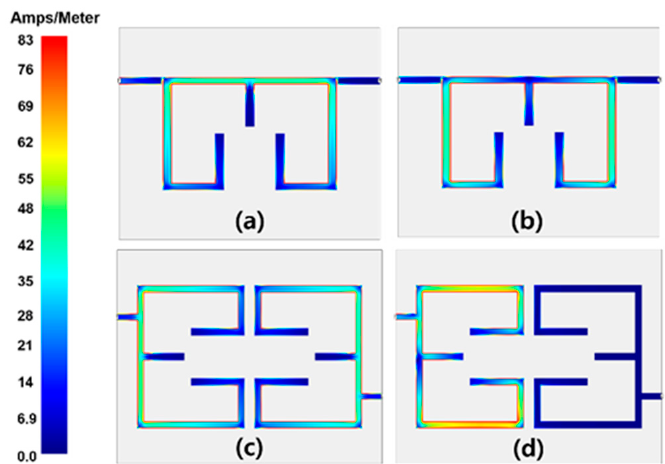
Figure 3. Current density of proposed resonator and BPF at different resonant frequencies: ( a ) and ( c ) 7.45 GHz (odd-mode), ( b ) and ( d ) 13.92 GHz (even-mode).